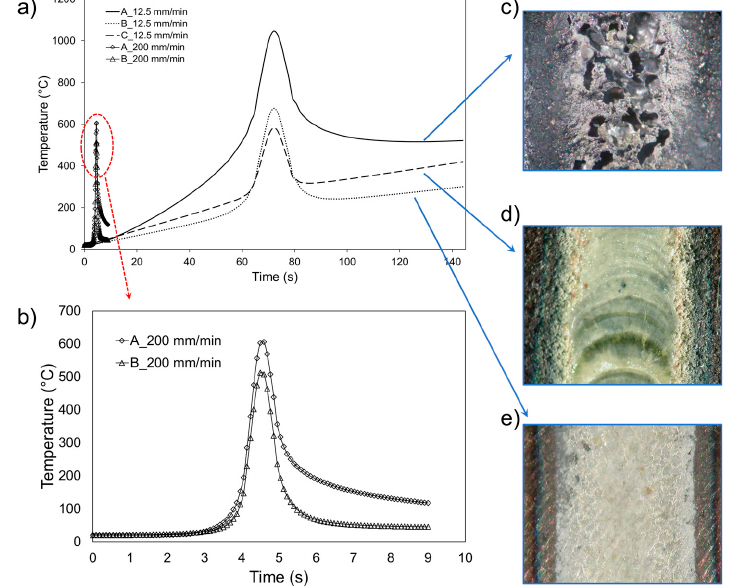
Figure 5. Computed transient temperature profiles: ( a ) test Cases A, B, and C at 12.5 mm/min; ( b ) particularly of test Cases A and B at 200 mm/min. All profiles were acquired at half length of the laser track at the irradiated surfaces. Surface macrographs of the treated coatings: ( c ) material loss damage; ( d ) cracking; ( e ) effective treatment with homogenous rutile layer.